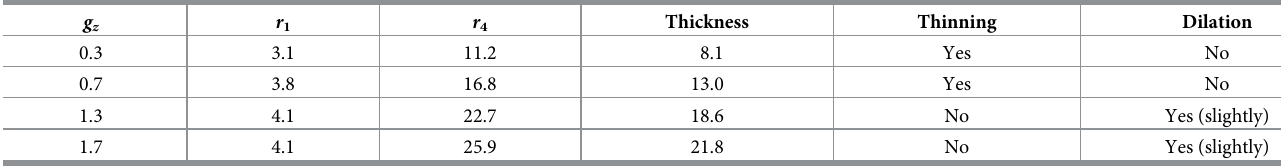
under g = g = 1. Length unit: mm. z r θ